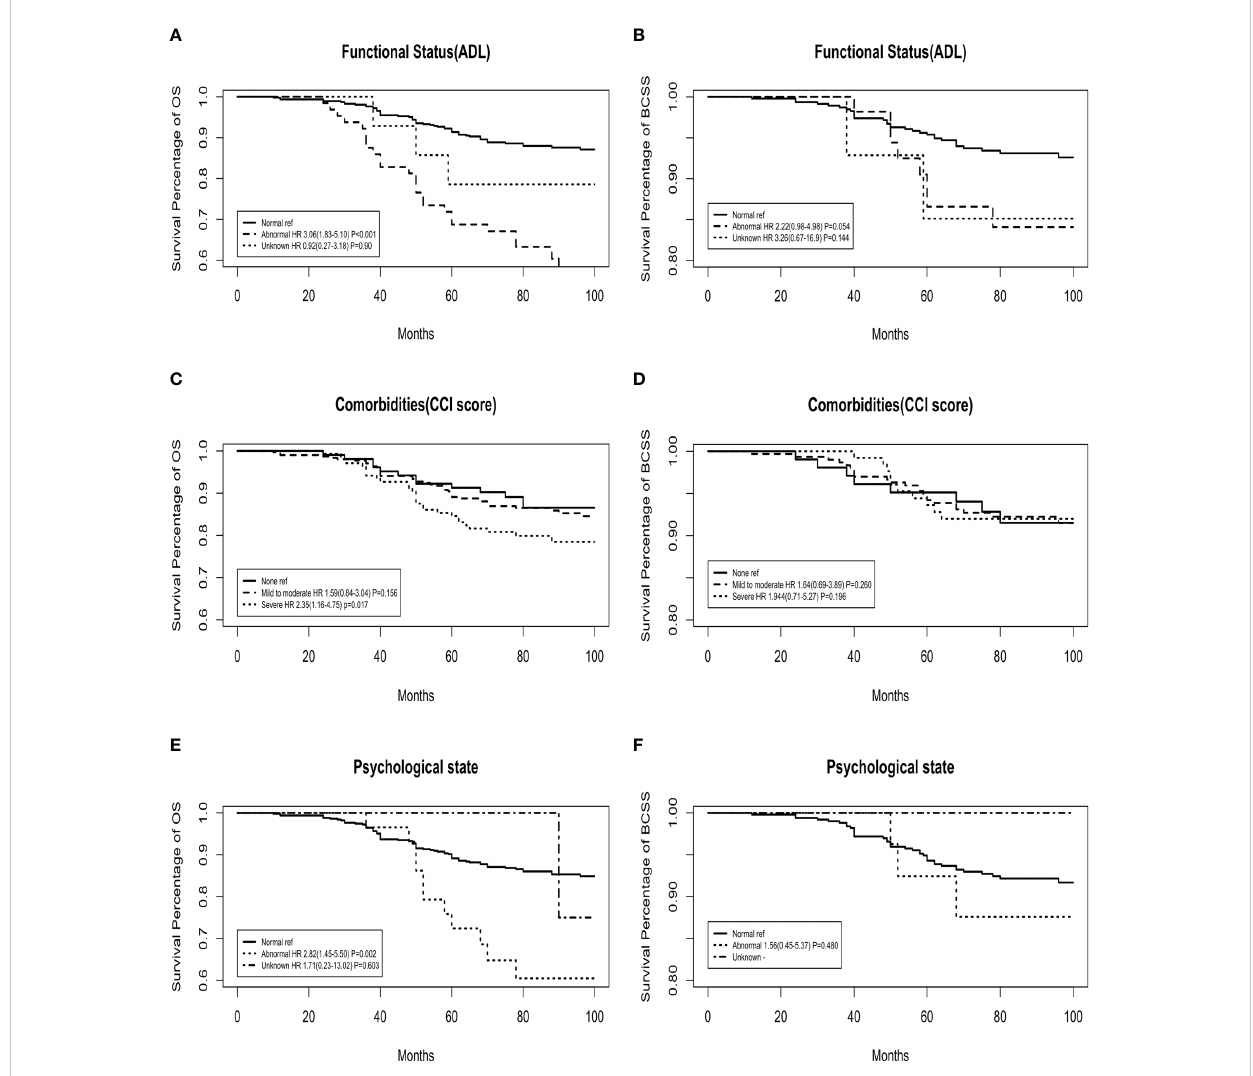
FIGURE 2 Adjusted overall survival (OS) and breast cancer-speci fi c survival (BCSS) curves for functional status, comorbidities, and psychological state domains of the geriatric assessment. (A, C, E) OS curves; (B, D, F) BCSS